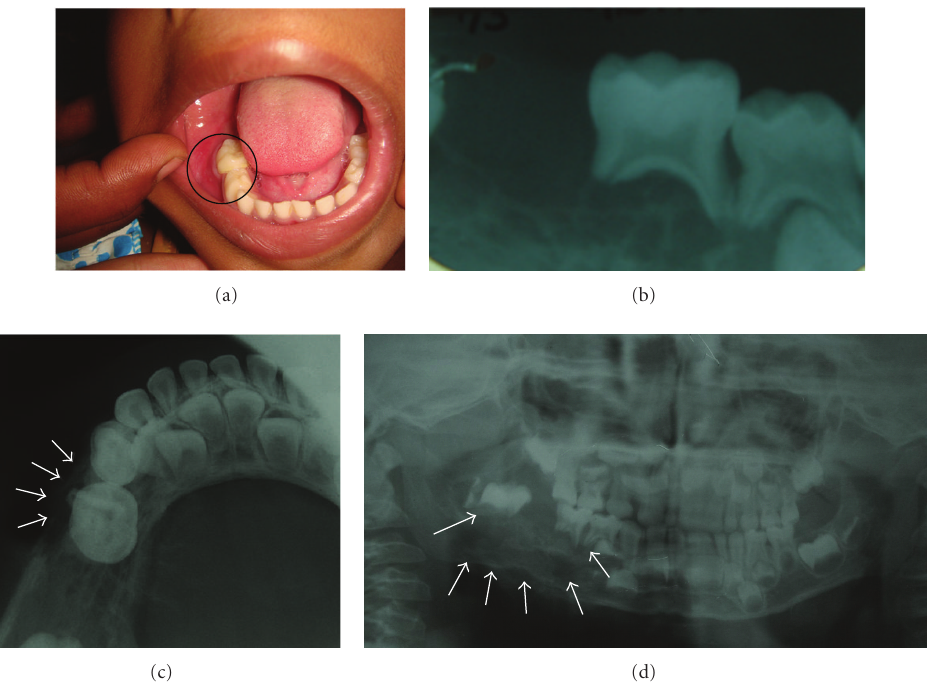
Figure 1: (a) Erythema of the vestibular mucosa in relation to 84 and 85. (b) Intraoral periapical radiograph showing resorption of roots of 84, 85, periapical radiolucency, and displaced tooth buds. (c) Mandibular occlusal radiograph showing erosion of the buccal cortex in relation to 85. (d) Panoramic radiograph showing lytic lesion over the right mandible. Note the irregular lower border of the mandible along with the displaced tooth bud of 46